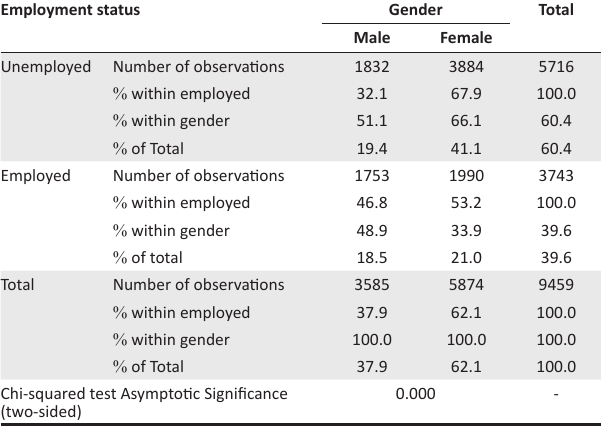
TABLE 2: Employment and gender cross-tabulation for 2014.